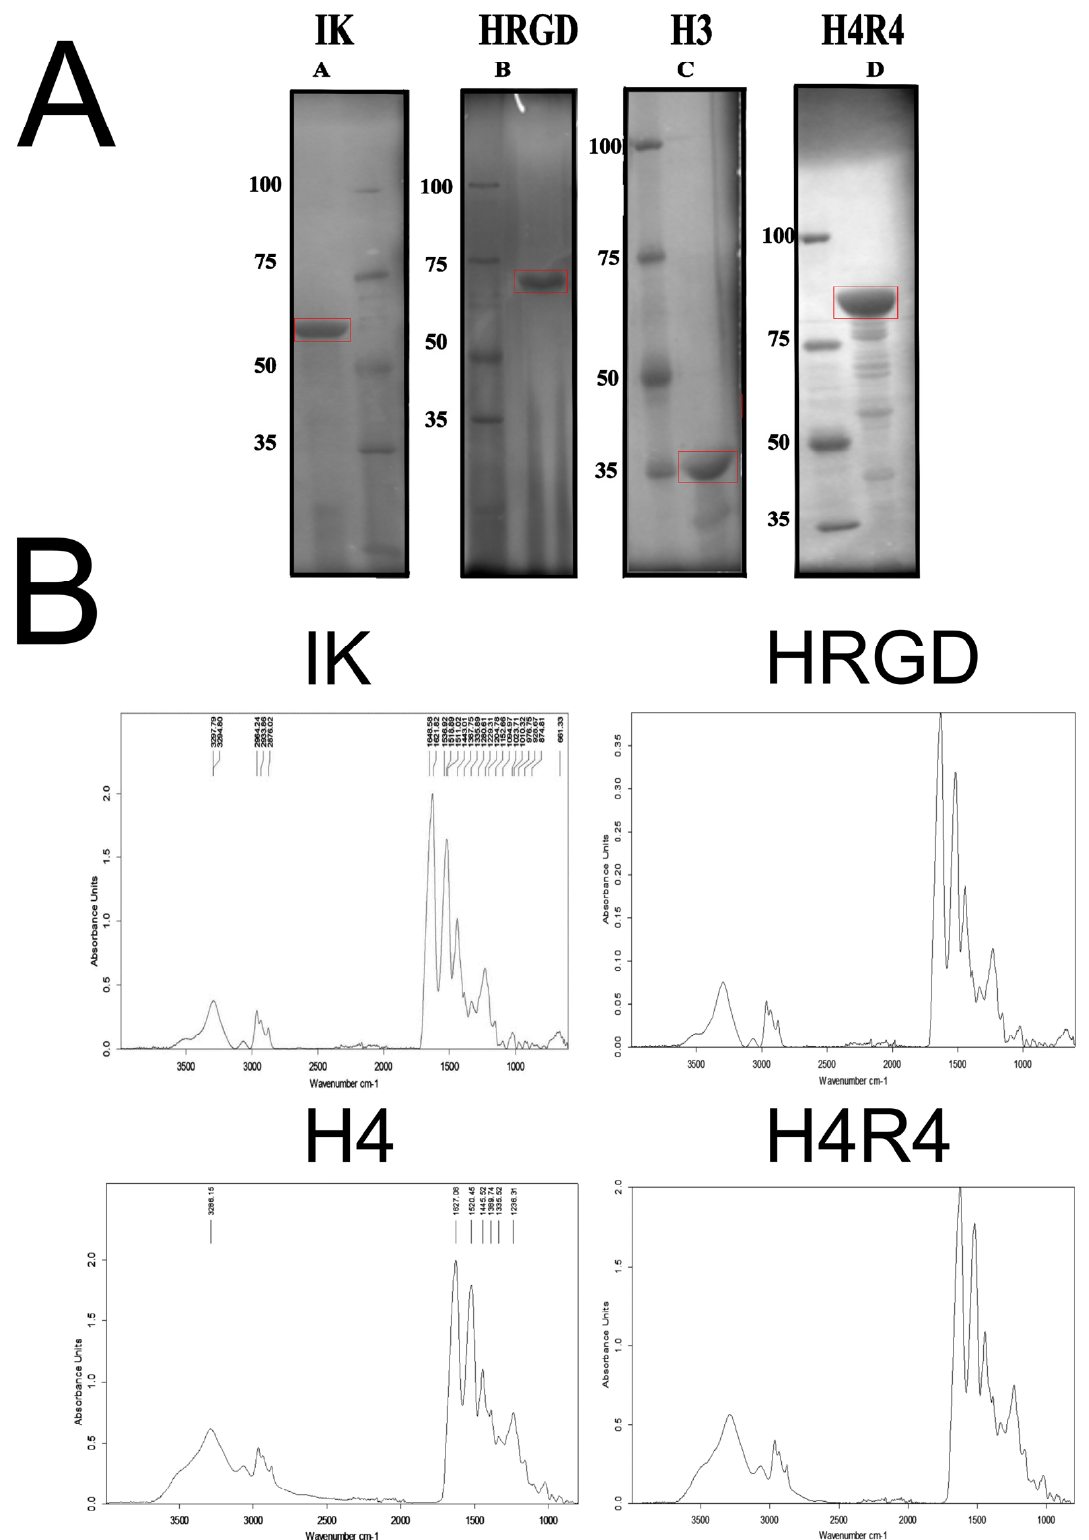
Figure 3. Characterization of the purity of ELRs. ( A ) SDS-PAGE of purified ELRs. The MW of the SDS-PAGE protein marker bands is indicated on the left side. The bands corresponding to the purified ELR are included in a red box. The theoretical MW for IK, HRGD, H3, and H4R4 are 52 kDa, 60.7 kDa, 31.9 kDa, and 80.7 kDa, respectively. ( B ) FTIR spectra of the purified ELRs.